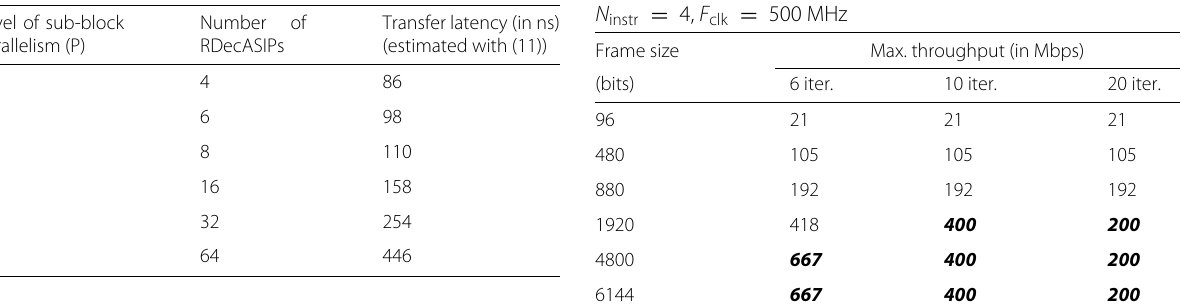
Table 3 Configuration transfer latency in nanosecond for different levels of sub-block parallelism